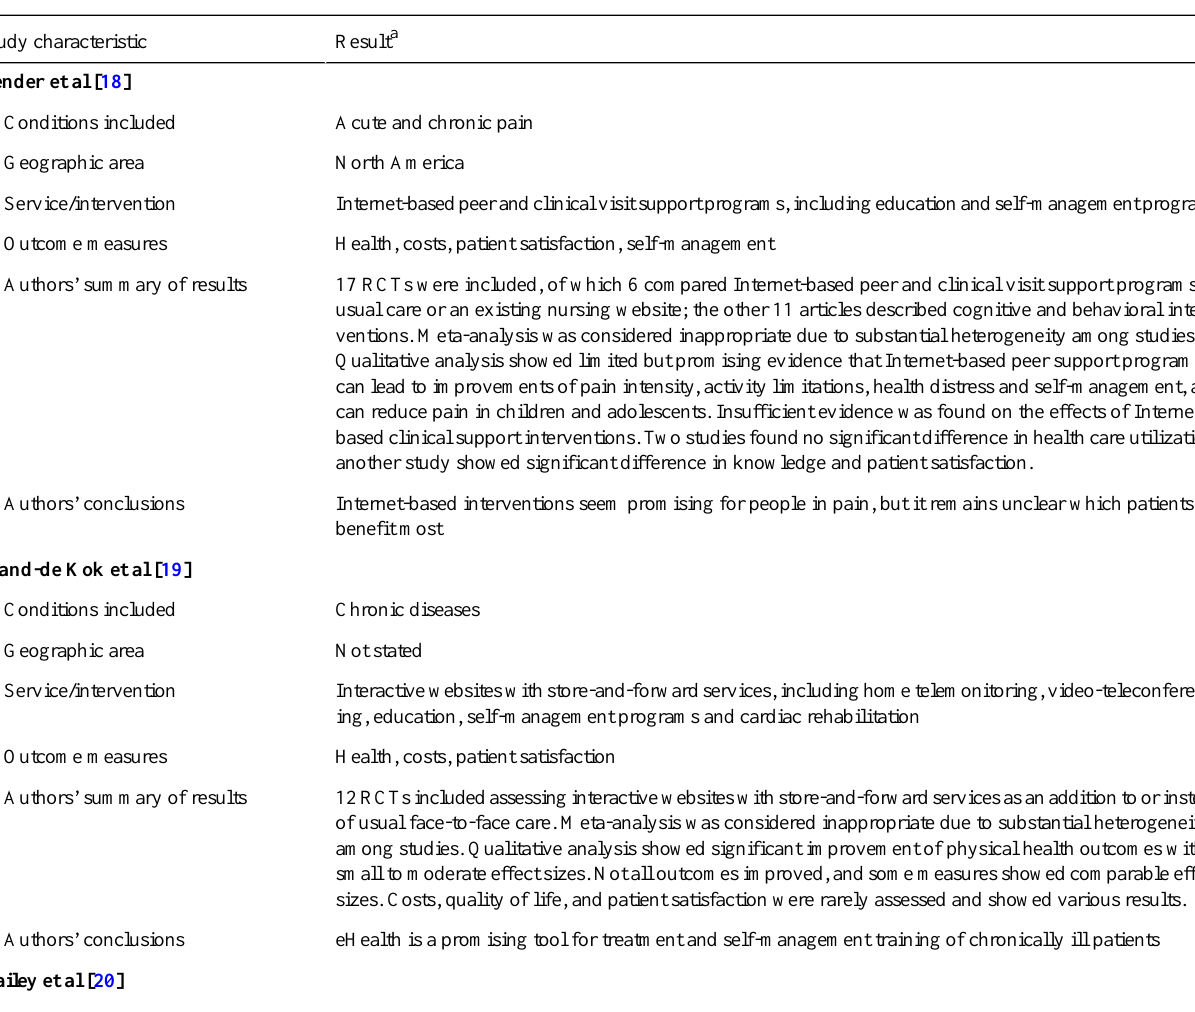
Table 4. Systematic reviews and meta-analyses in which promising evidence on the effectiveness/cost-effectiveness of eHealth interventions was